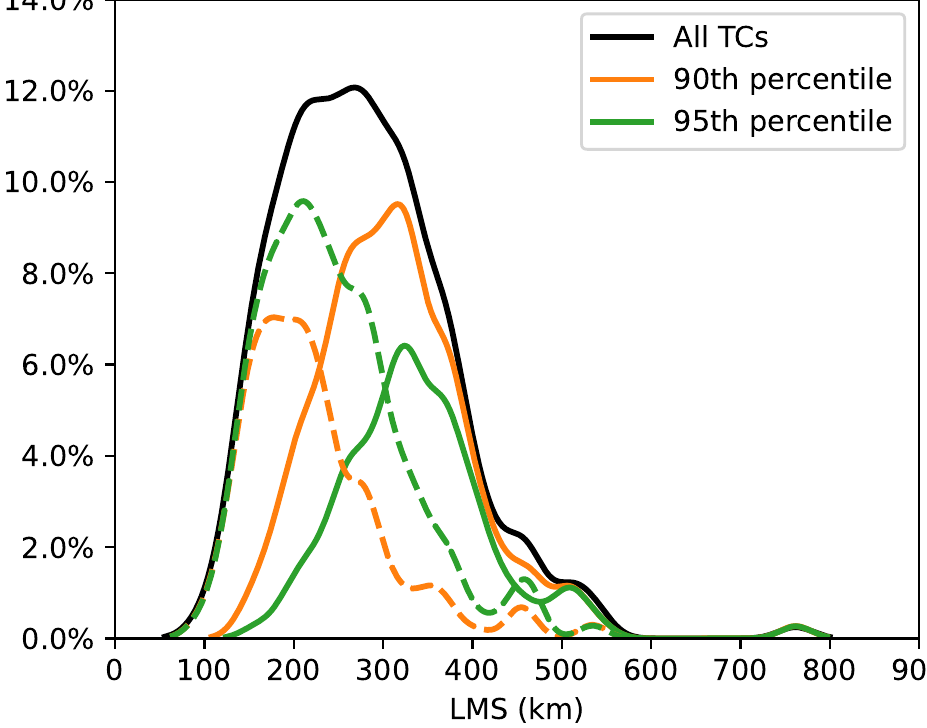
Figure 11. Same as Figure 4, but for the results in the Monte Carlo